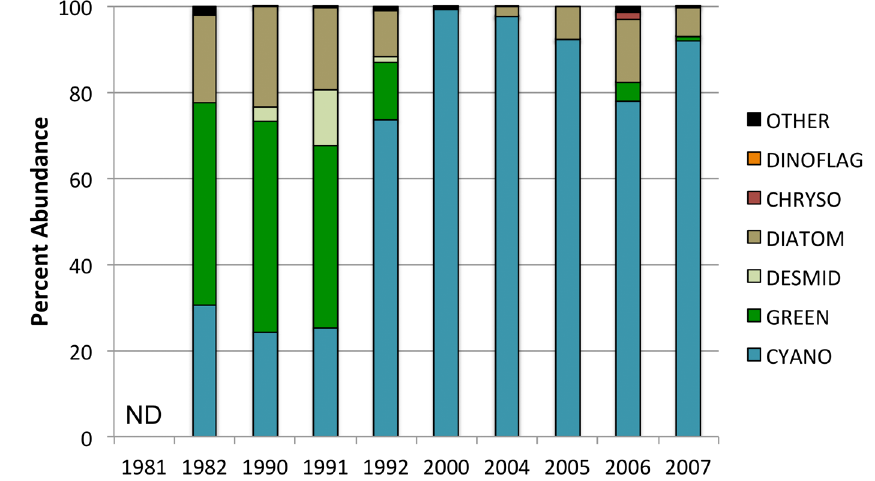
Figure 7. Mean summer phytoplankton community composition as percent of cell abundance (top panel) and percent of total biovolume (bottom panel) for the inner bay of Green Bay. Post-invasion years are